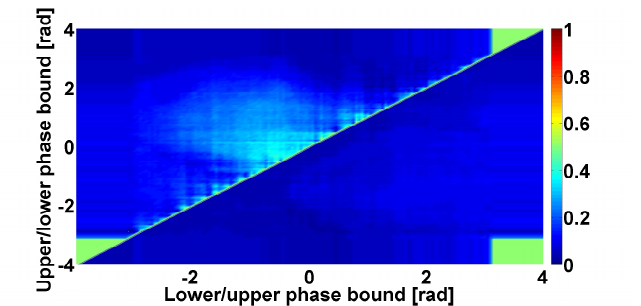
Figure 12. Example of Phase CWS AUC diagram. Tremor signals in antagonist muscles of left arm with hyperkinetic movements in PD and ET patients are analyzed. Cross-wave trains in the frequency range from 10 to 37 Hz are considered. The axes are the same as in Figure 8.